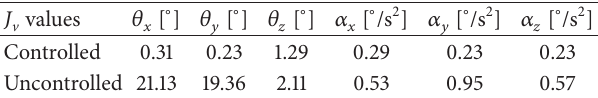
Table 3: 𝐽 V values of position and acceleration data for controlled and uncontrolled suspension system.